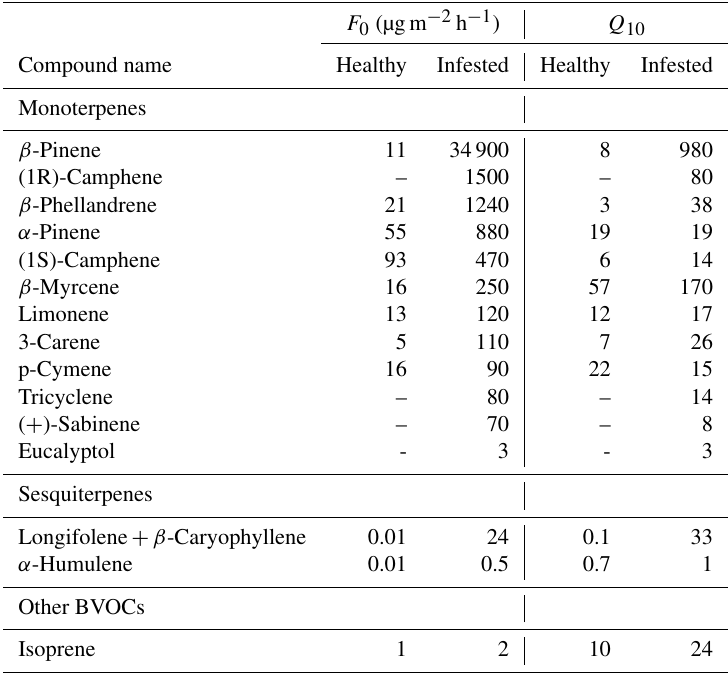
Table A2. The difference between healthy and infested trees when applying the calculations for the Q 10 temperature dependency. F 0 is the reference emission rate standardized at 30 ◦ C. The Q 10 coefficient indicates the emission rate change for every 10 ◦ C temperature difference and is therefore a measure of temperature